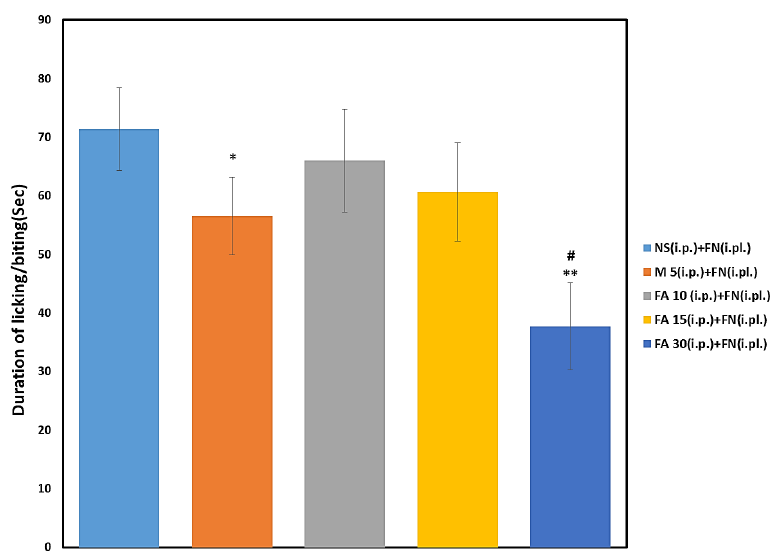
Figure 1. Effects of i.p. injection of morphine (5 mg/kg) and different doses of folic acid (10, 15 and 30 mg/kg) on 1st phase (0-5 min) response to formalin-induced pain in mice. * P < 0.05 and ** P < 0.01 vs control group (NS+FN); # P < 0.05 vs morphine group (M+FN). NS: normal saline; FN: formalin; FA: folic acid; M: morphine; i.p.: intraperitoneal; i.pl: